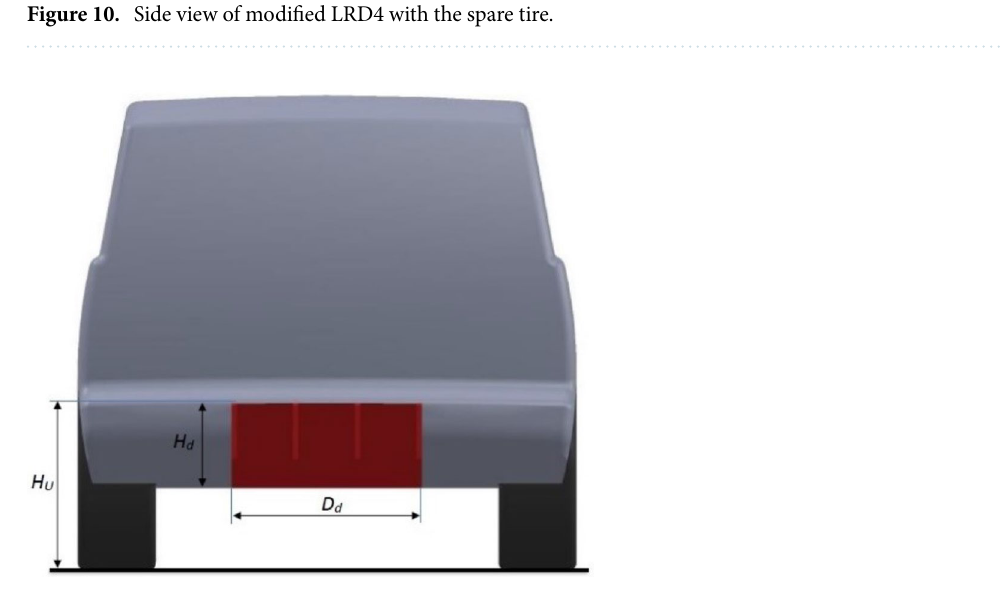
Figure 11. Back view of modified LRD4 with the spare tire.